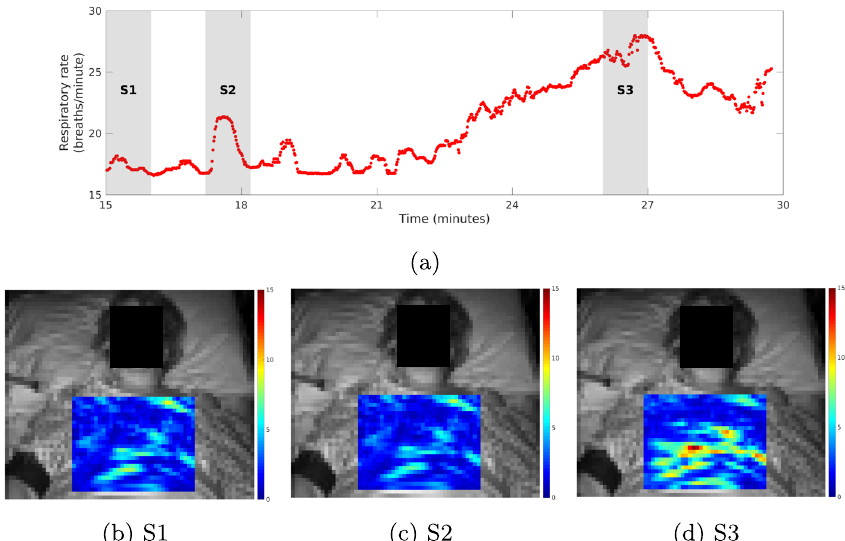
Fig. 5 Visualisation of the local respiratory effort of a patient later diagnosed as having a ruptured diaphragm, as con fi rmed by chest CT, and a right-sided pneumothorax. ( a ) Respiratory rate estimated from the camera. Heat maps show the magnitude of the respiratory effort from regions on the chest during time stages ( b ) S1, ( c ) S2 and ( d ) S3. Each super-pixel in the heat maps was coloured according to the amplitude of the respiratory signal (in pixel units) computed from the 30 × 30 ROI centred on the super-pixel . The non-stationary respiratory rate was measured with a sustained increase in respiratory rate from t = 18 min to t = 27 min. A progression towards subdiaphragmatic left- lateral respiratory movements is observed as increased signal intensity over the lower left-side in the respiratory map for stage